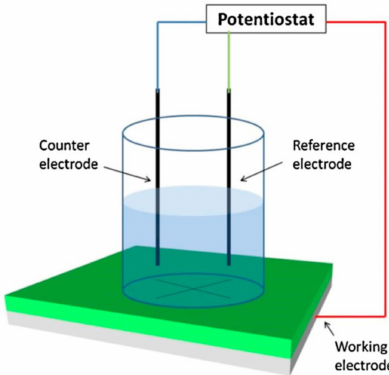
Figure 8. Schematic diagram of the electrochemical impedance spectroscopy (EIS) measurement. Adapted from [62], with permission from © 2014